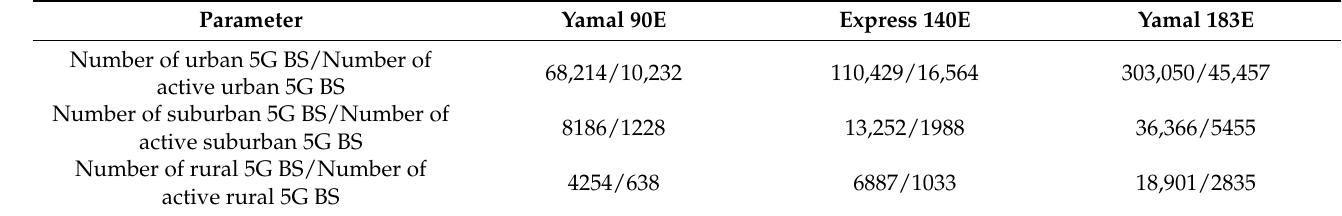
Table 4. Parameters of each Monte Carlo simulation step (urban/suburban (rural)